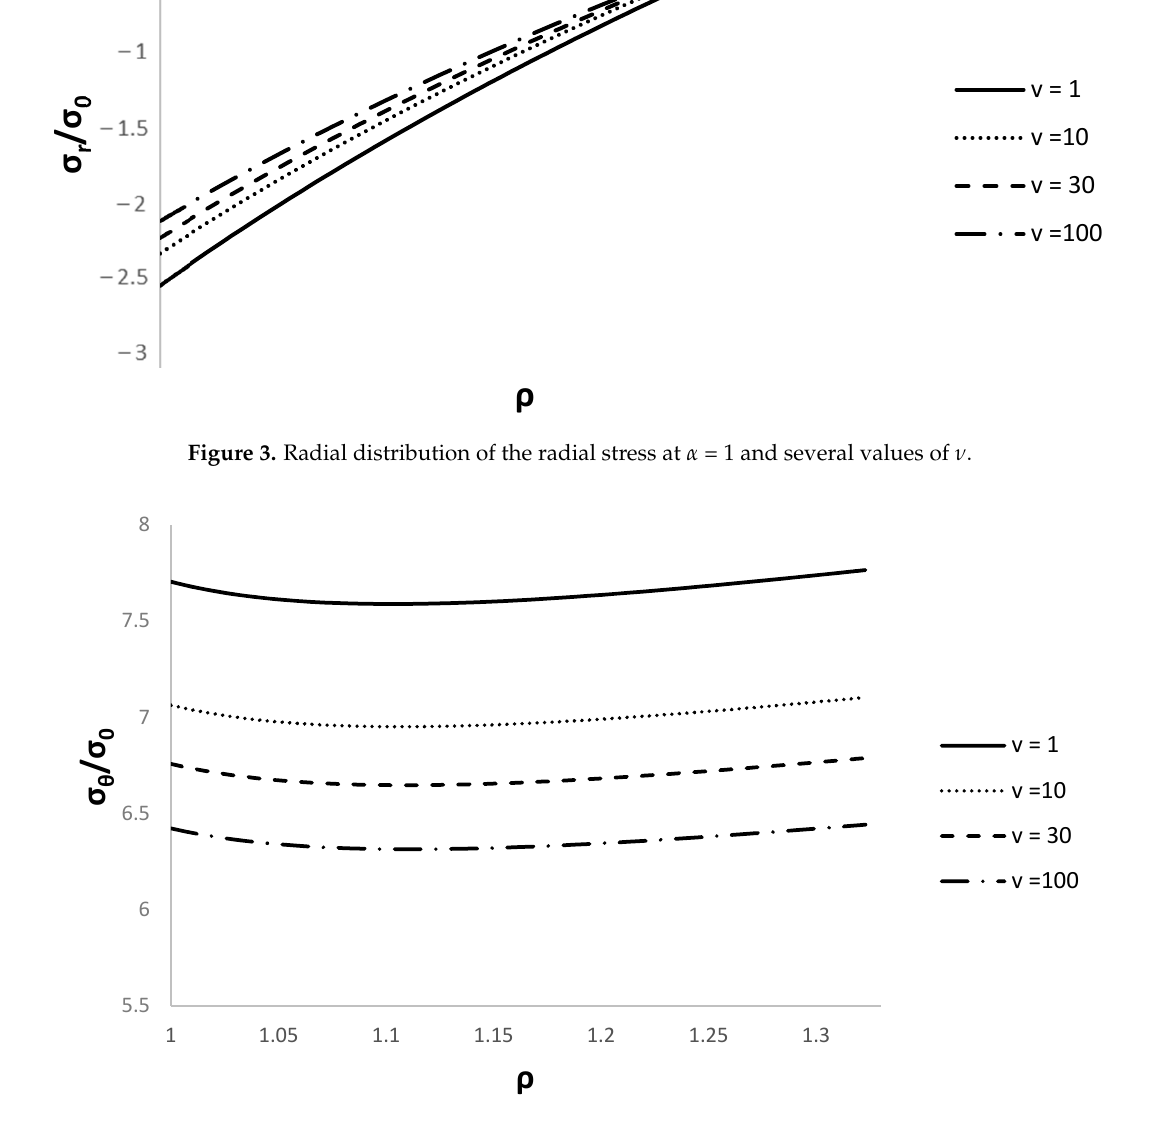
Figure 4. Radial distribution of the circumferential stress at α = 1 and several values of ν .